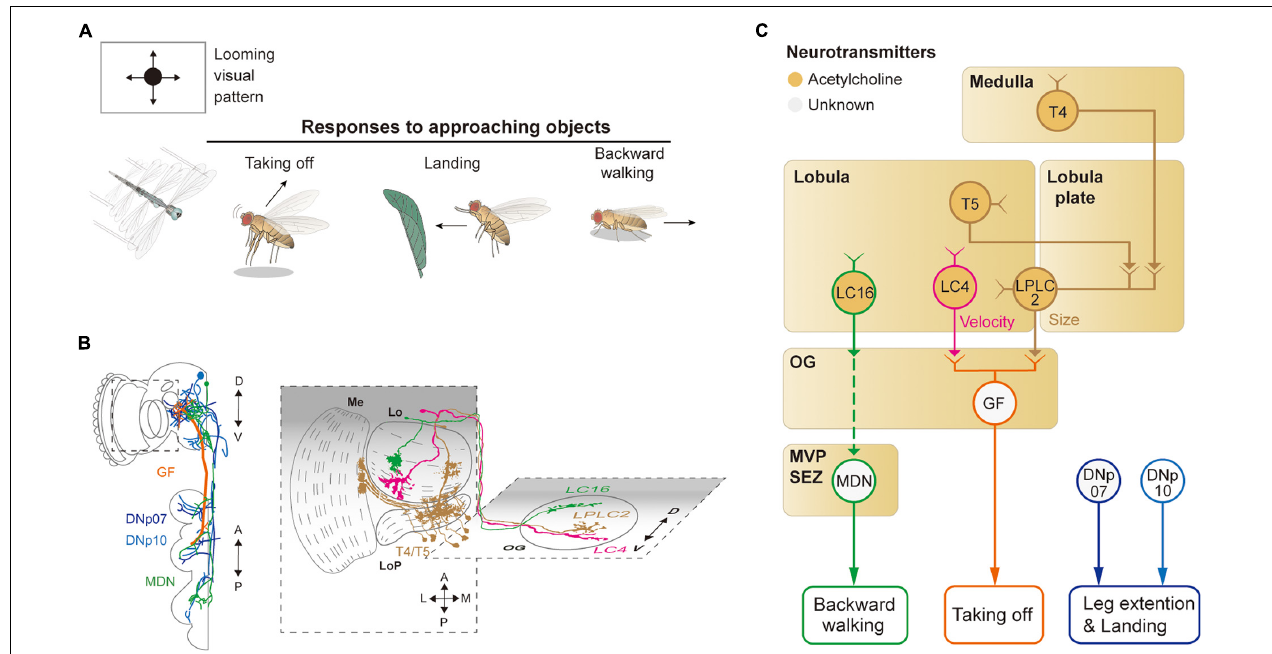
FIGURE 4 | Neural circuits underlying avoidance behavior to approaching (looming) visual objects. (A) Approaching visual objects may induce distinct behaviors, such as take-off, landing, and backward walking, depending on their size and velocity. (B) Schematic illustration of neurons related to the loom avoidance behavior. Graphical depiction is adapted from Sen et al. (2017), Namiki et al. (2018), Wu et al. (2016), and Feng et al. (2020). The colors of neurons match those in panel (C) . Me: medulla, LoP: lobula plate, Lo: lobula, OG: optic glomeruli. (C) Schematic diagram of neural circuits related to loom-induced avoidance behavior. In optic glomeruli, LPLC2, LC4, LC16 VPNs are shown to be sensitive to a looming visual pattern. LPLC2 cells integrate signals from T4/T5 cells in the lobula plate to detect approaching objects (ocher outline). LC4 cells respond to the looming pattern with their dendrites in lobula (pink outline). LPLC2 and LC4 cells pass these signals to giant fibers (GFs), which induce the take-off response (orange outline). Approaching objects may also cause the landing response via DNs, DNp07, DNp10 (blue outline). Moonwalker descending neurons (MDN) (green outline) receive the visual information from LC16 cells and induce backward walking. The face color of a circle represents the type of neurotransmitters released by a neuron, and the line color of a circle matches that of the neuron in panel (B) . OG: optic glomeruli, MVP: medial ventral protocerebrum, SEZ: subesophageal